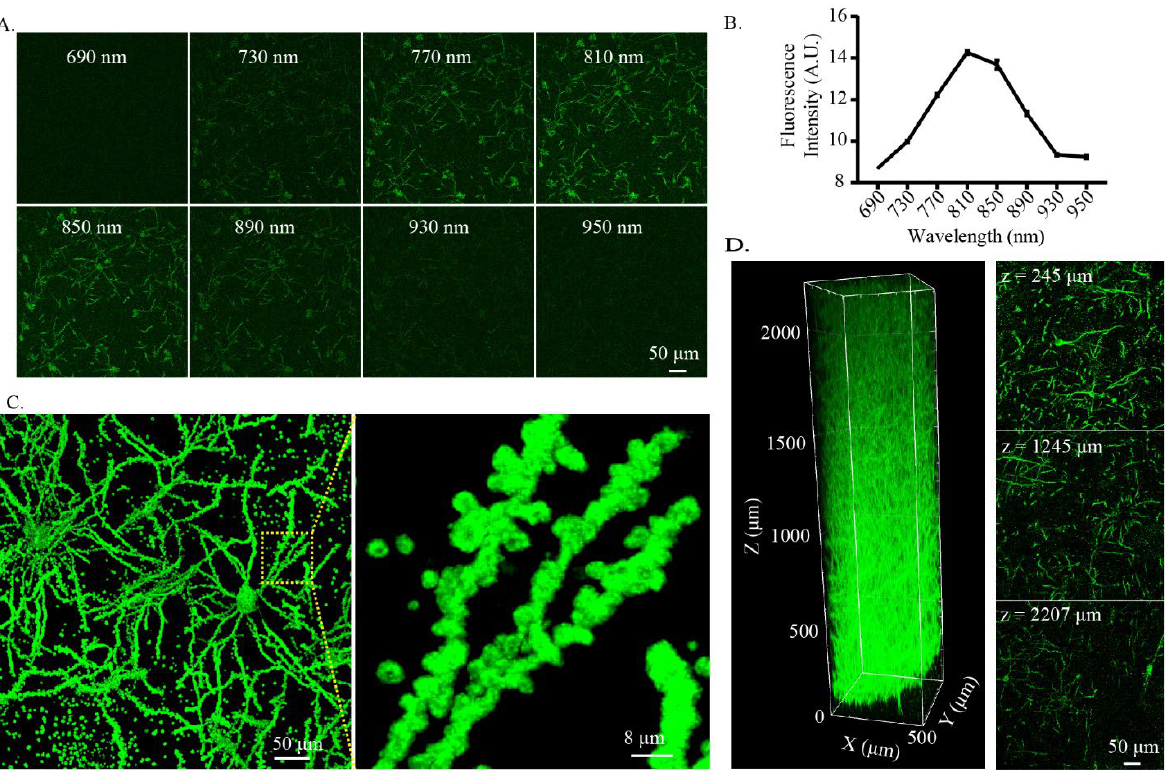
Figure 3. Three-dimensional imaging of cleared Golgi-stained tissue using two-photon microscopy. ( A , B ) Testing of the wavelength for excitation of the cleared Golgi-stained tissue. ( A ) The same position of the tissue was excited with 690–950 nm wavelengths with 40 nm interval and captured using an emission filter tuned to 495–540 nm. ( B ) Statistics of the fluorescence signal intensity of Golgi-stained samples under different excitation wavelengths. The plot is shown as the mean ± SEM (n = 3) ( C ) Three-dimensional imaging of the fine morphology of cleared Golgi-stained tissue using two-photon microscopy. The images were obtained with 810 nm excitation light and captured at 495–540 nm. The left panel shows the neuronal cell bodies and fibers after clearing and the right panel shows the dendritic spines. ( D ) Three-dimensional imaging of larger volume cleared Golgi- stained tissue using two-photon microscopy. Left panel: Three-dimensional rendering of the cleared Golgi-stained tissue. One millimeter thick slices were used for clearing and imaging (about 2 mm thick after clearing and incubating in PBS). Right panel: Sectional images at different